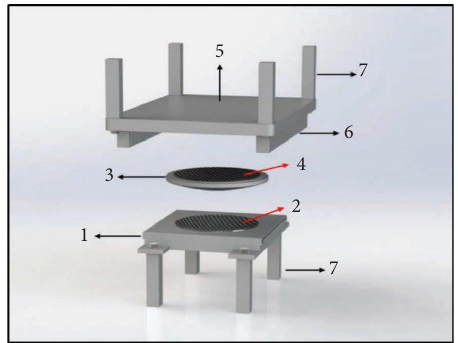
Figure 2: Confguration of a spherical